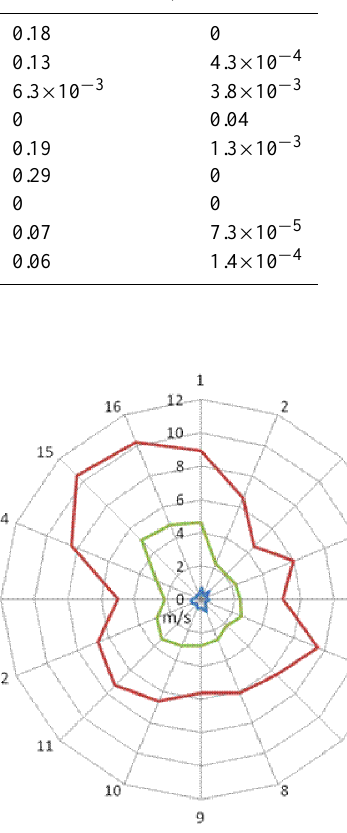
Fig. 3. Wind rose depicting the monthly average, minimum and maximum wind speed and direction during April 2006 at a station in the Beijing urban area (39.48 ◦ N, 116.28 ◦